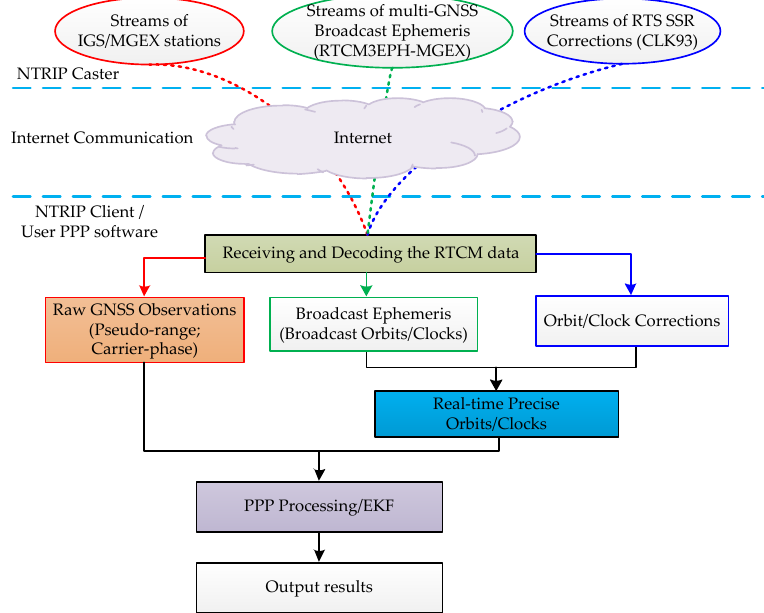
Figure 2. The flow diagram of real-time precise point positioning (PPP) processing.